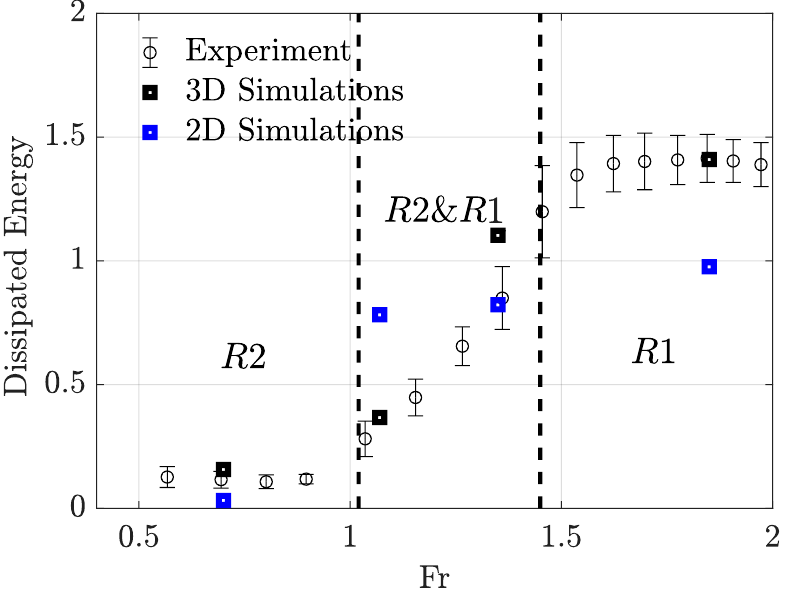
Figure 3. The normalised dissipated energy as a function of Fr number computed by two-dimensional and three-dimensional no-model simulations and compared with experimental measurements [59].